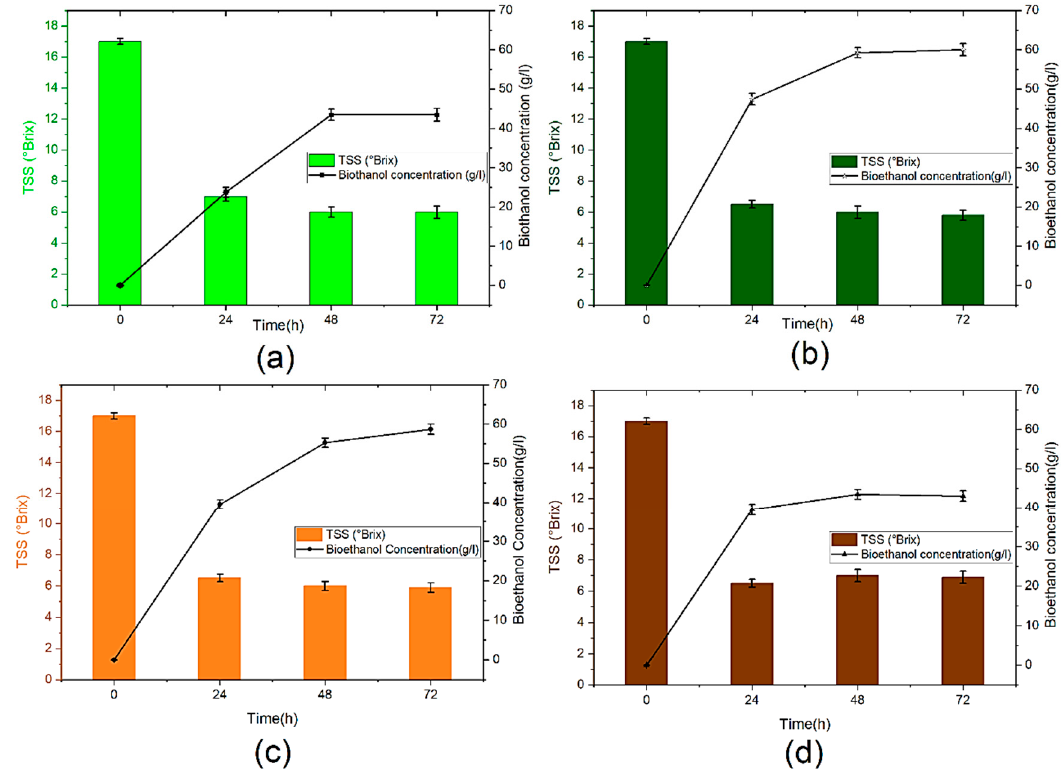
Figure 2. Bioethanol concentration and TTS (°Brix) content during anaerobic fermentation: ( a ): B10, ( b ): B15, ( c ): B25 and ( d ): B50.